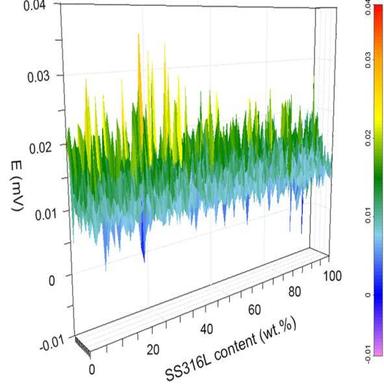
SVET images of the graded material in 3.5 wt.% NaCl solution after 1 h of immersion.